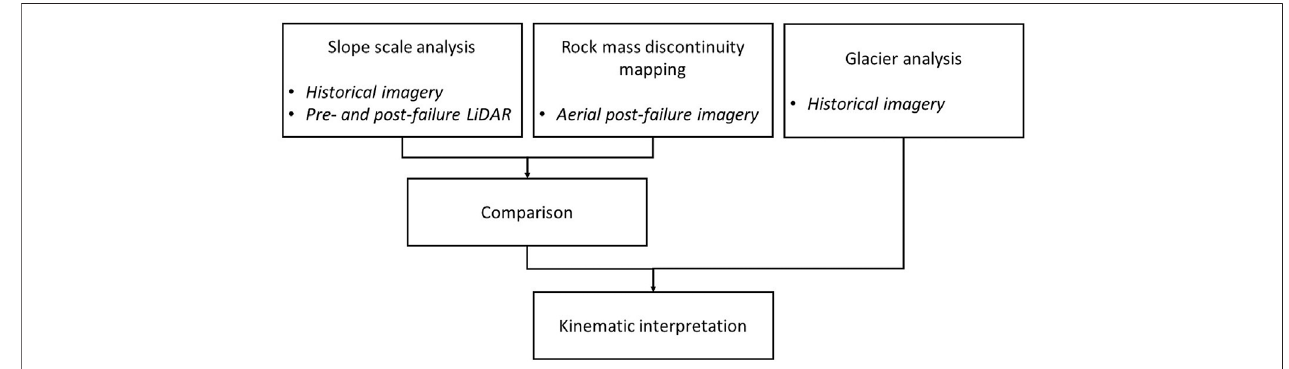
FIGURE 2 | Flowchart showing the types of input datasets used in the various stages of the landslide characterization.